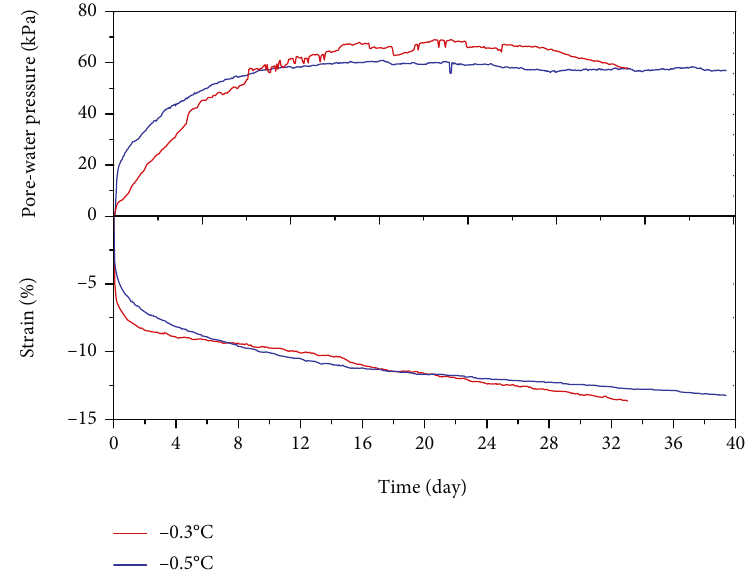
Figure 10: E ff ect of soil temperatures on test results (KY-03 and